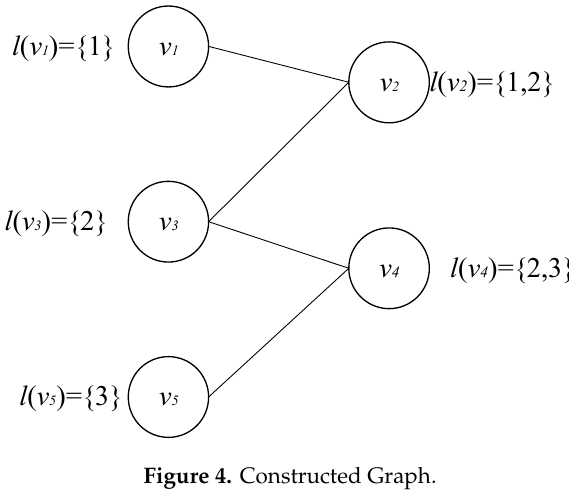
Figure 4. Constructed Graph